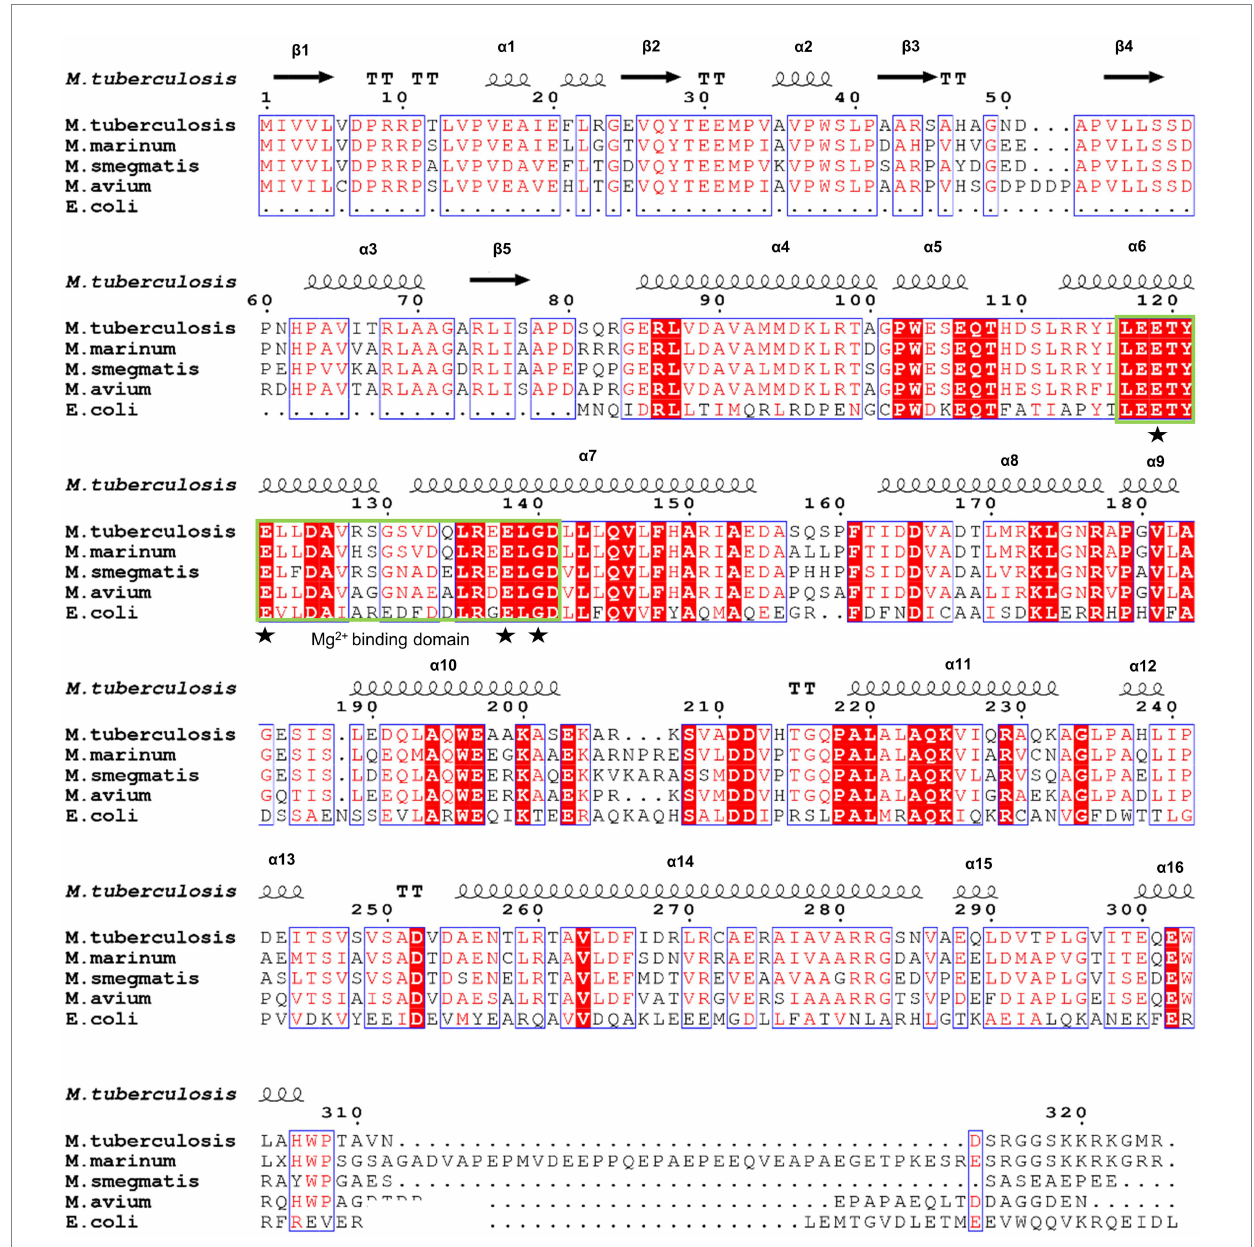
FIGURE 5 Sequence alignment of Mtb-MazG with its orthologs. Sequence alignment was performed using the ClustalX and ESpript v.3.0 programs. Identical and similar residues are shown in white text on a red background and in red text on a white background, respectively. The magnesium binding domain was highlighted with a green box. The star denotes residues that are bound with